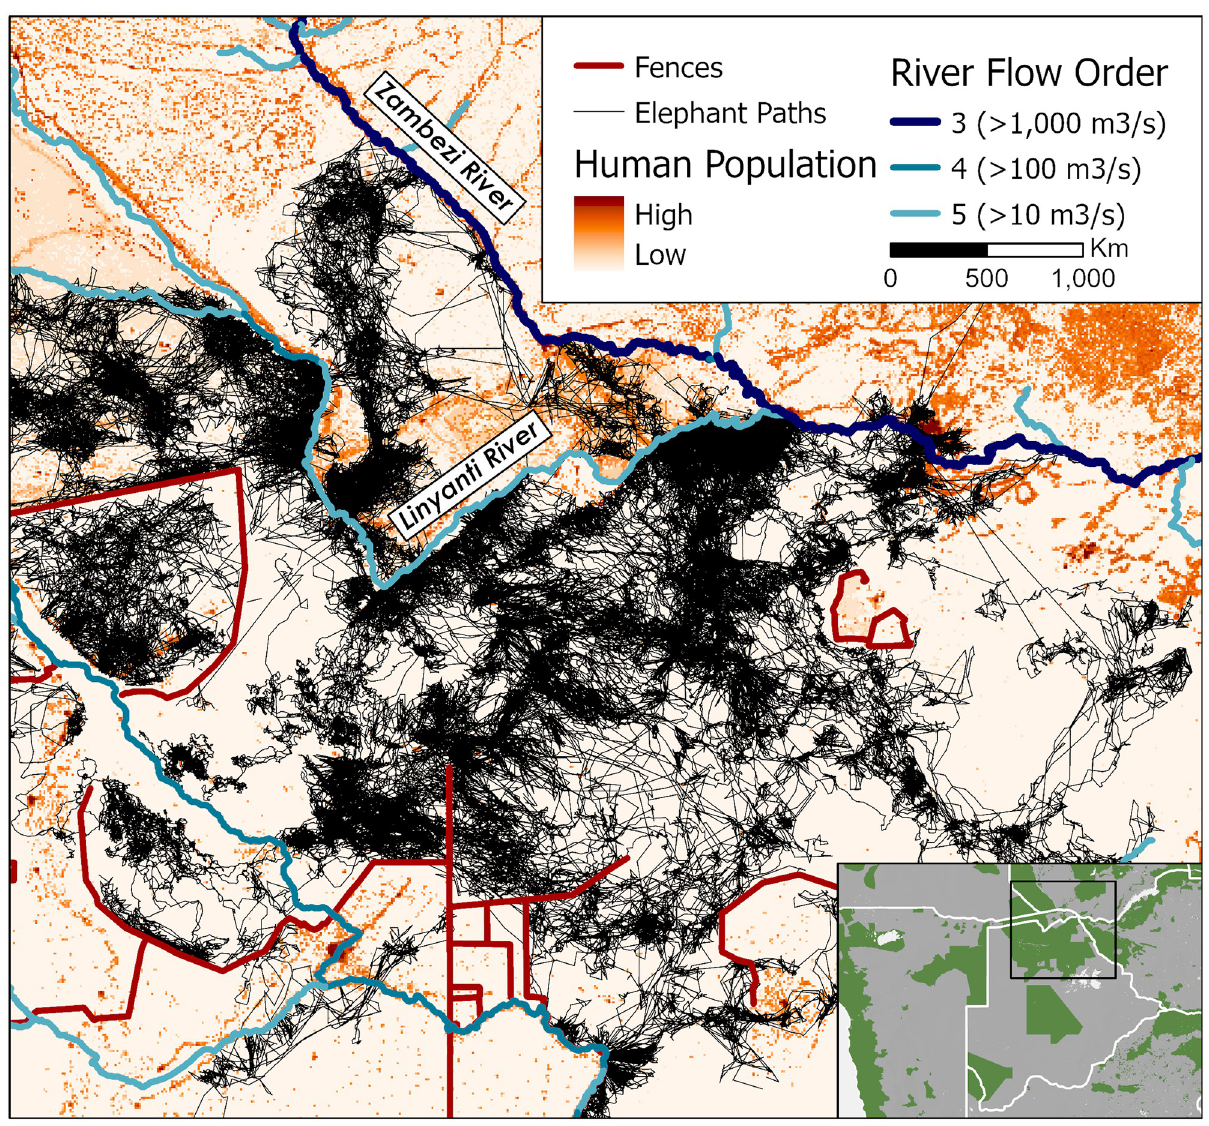
Fig 8. Map of elephant paths and human population in the Chobe cluster. Telemetry paths of elephants (black) in the Zambezi and northern Botswana regions overlaid on a human population density map (orange) [31]. Rivers (blue-purple lines) [30] and fences (red lines) [4] also act as barriers to elephant movement. Green areas in the subset map mark protected areas from the WDPA